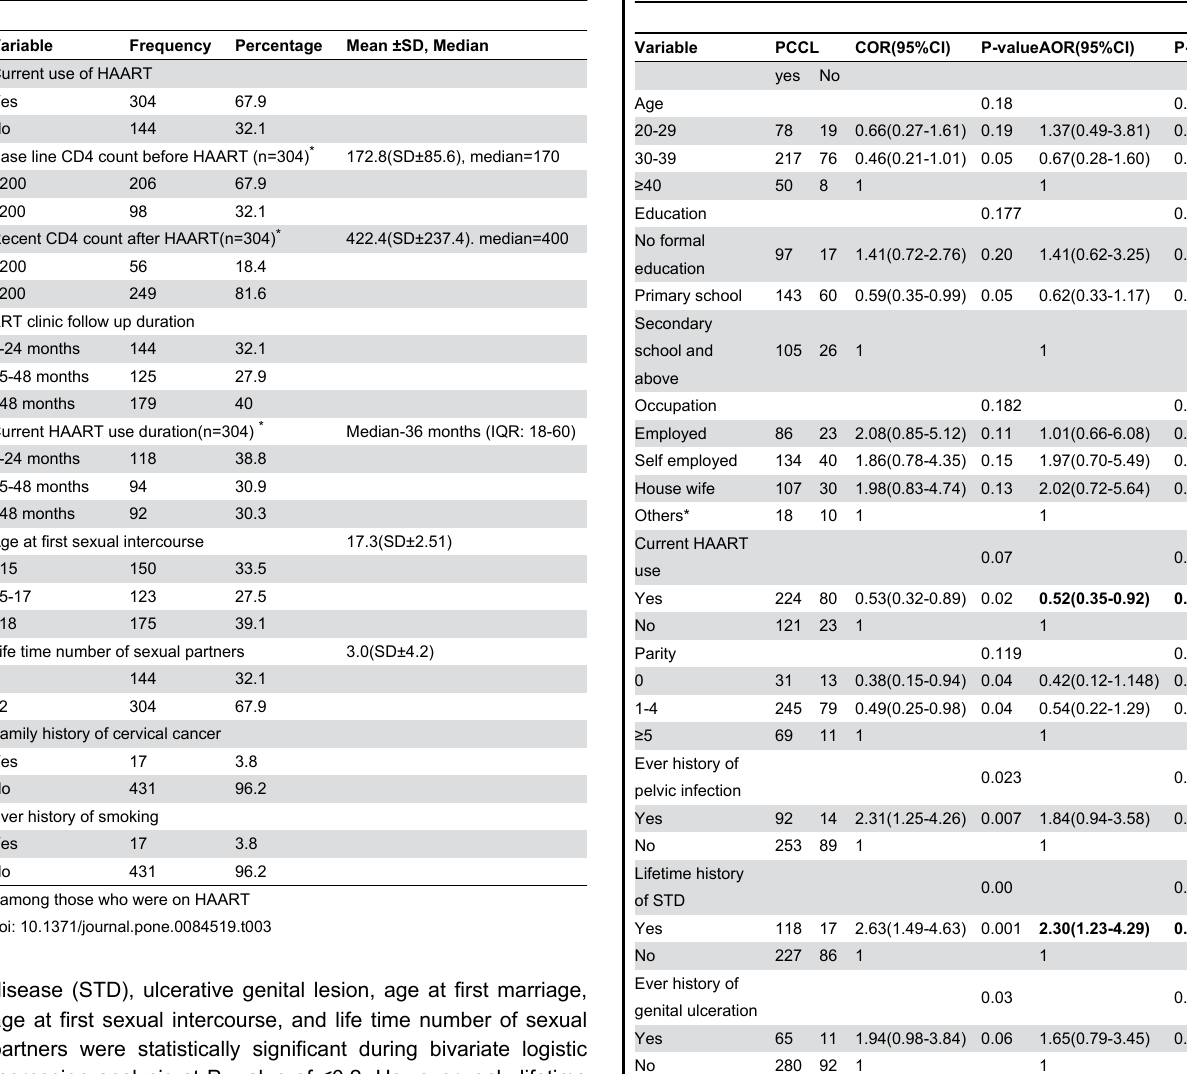
Table 3. Immunological, behavioral and other characteristics of the study participants, in three screening centers, Southern Ethiopia, 2013 (n=448).